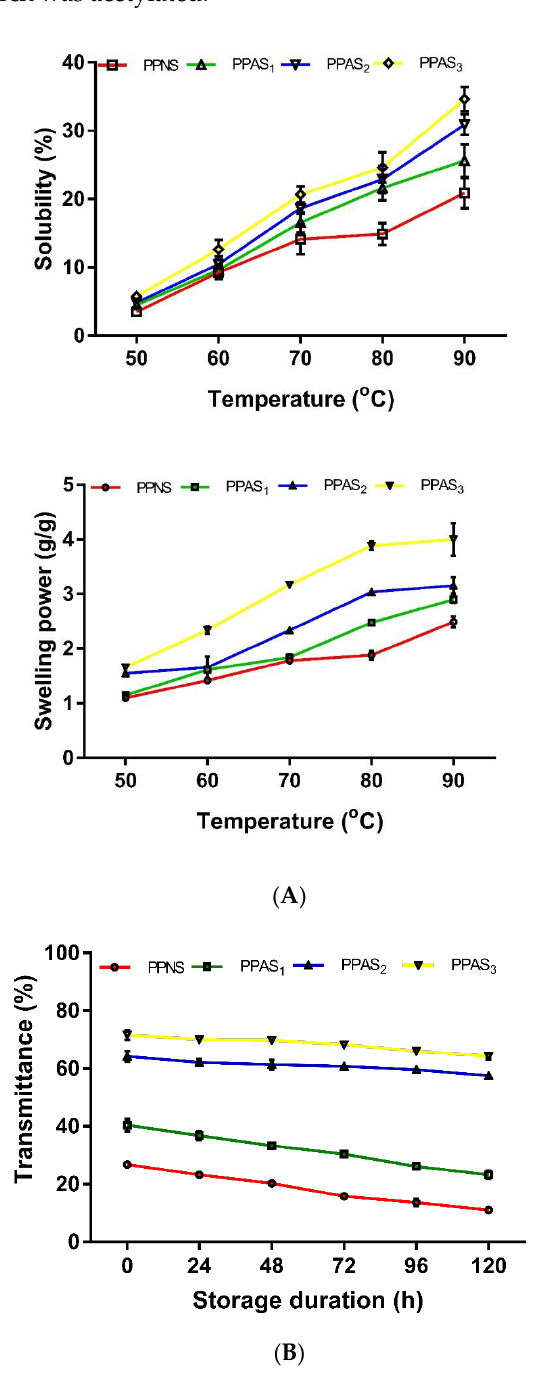
Figure 1. ( A ) E ff ect of temperature on solubility and swelling power of native and modified pigeon pea starches. PPNS—Pigeon pea native starch; PPAS 1 —Pigeon pea acetylated starch, DS 0.05; PPAS 2 —Pigeon pea acetylated starch, DS 0.09; PPAS 3 —Pigeon pea acetylated starch, DS 0.14. ( B ) E ff ect of storage duration on transmittance of native and modified pigeon pea starches. PPNS—Pigeon pea native starch; PPAS 1 —Pigeon pea acetylated starch, DS 0.05; PPAS 2 —Pigeon pea acetylated starch, DS 0.09; PPAS 3 —Pigeon pea acetylated starch, DS